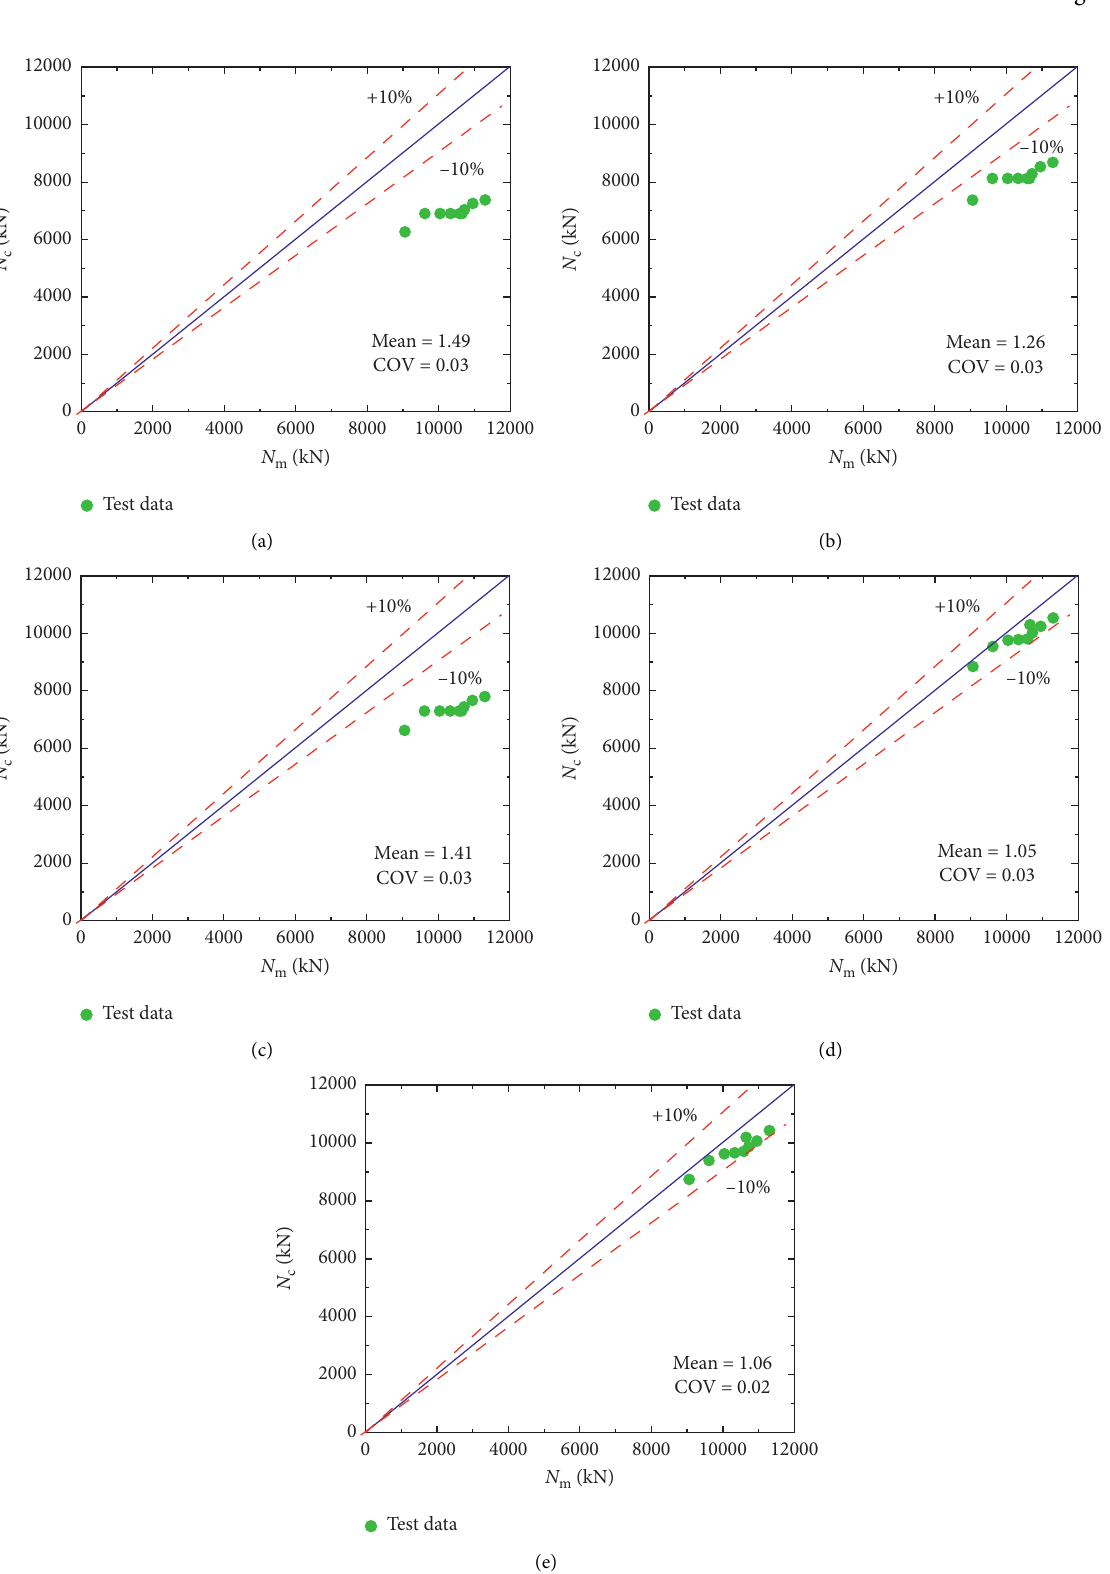
Figure 15: Comparison of test results with results predicted using (a) ACI 138–14 [23], (b) EN 1994-1-1 [24], (c) JGJ 138–2016 [25], (d) the proposed method, and (e) the simplified